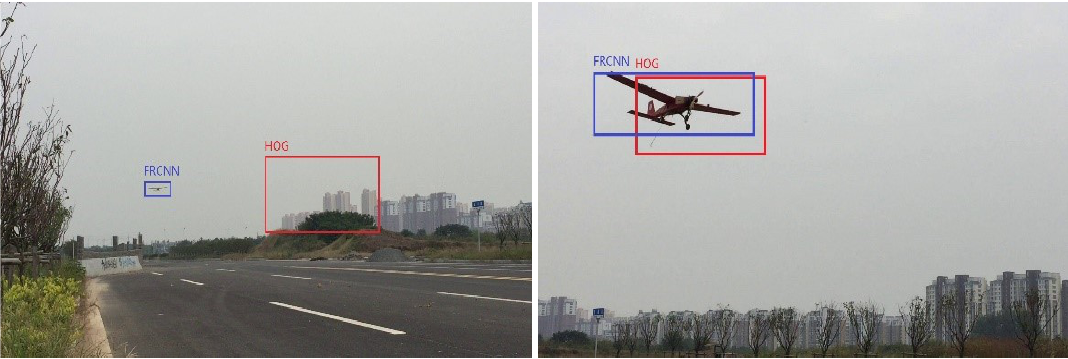
Figure 17. Detection performance of Faster RCNN and Histogram of Oriented Gradient (HOG) + Support Vector Machine (SVM).